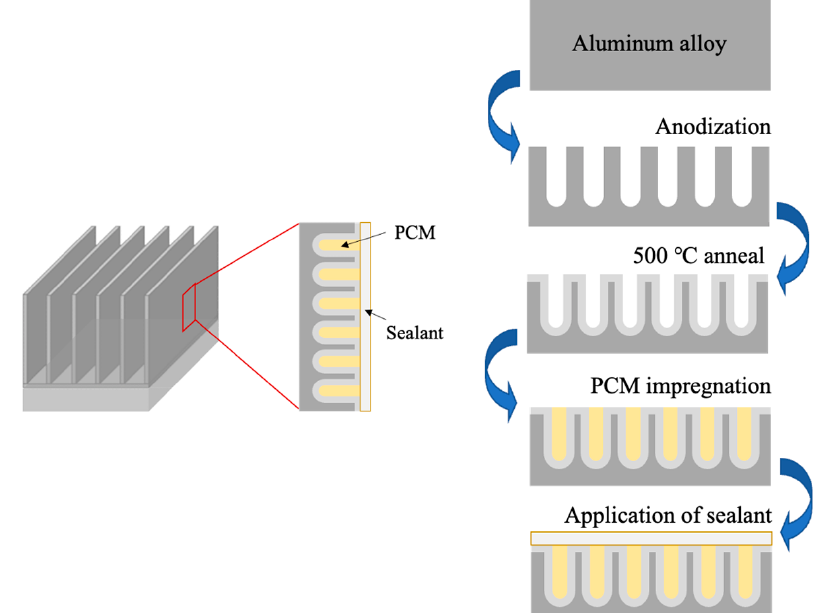
Figure 1. Schematic representation of the steps followed to generate a porous structure on the surface of a metallic component, anneal it, introduce the PCM, and seal it, to produce a metal-PCM composite at the microstructural level in the surface layer of the base alloy.